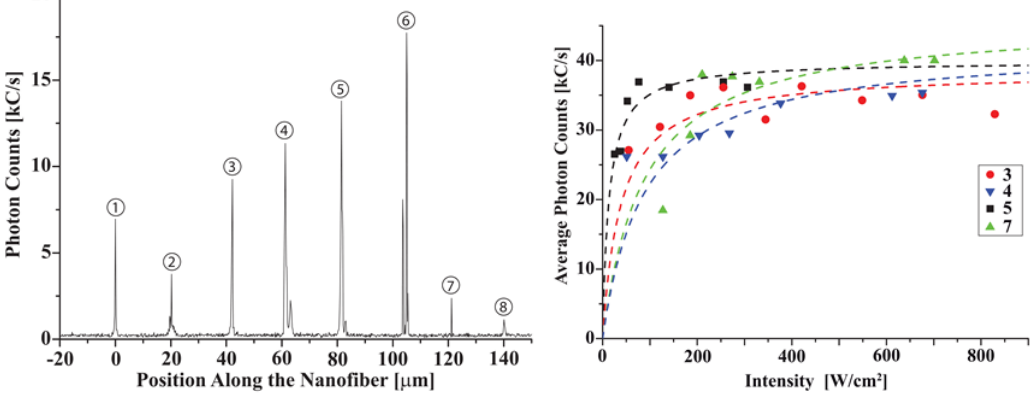
Figure 14. ( Left ) Fluorescence counts depicted through a nanofiber as each QD deposition site is individually excited through a microscope objective; ( Right ) Observed fluorescence count-rate for increasing intensities at positions 3, 4, 5 and 7 in (a), showing QD saturation. Reprinted with permission from [99]. Copyright 2012 Optical Society of America.